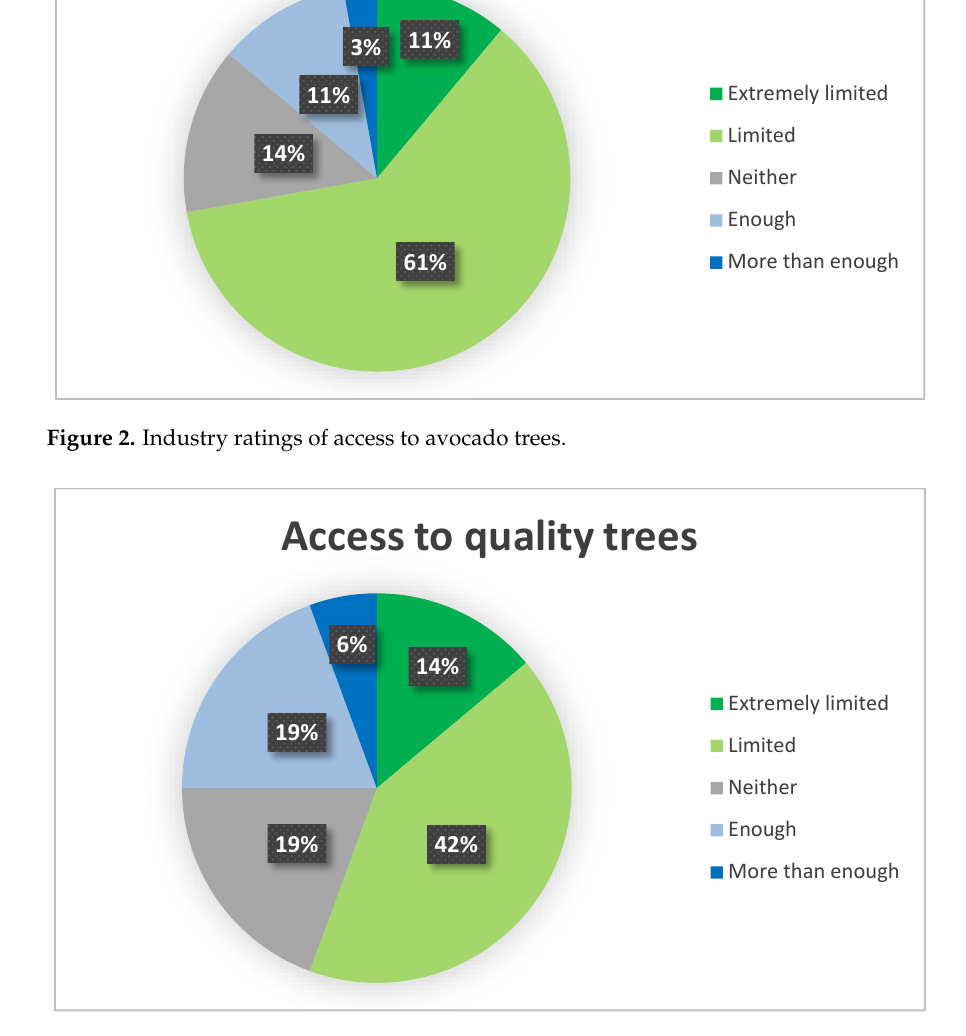
Figure 3. Industry rating of their access to the quality of avocado trees they want.